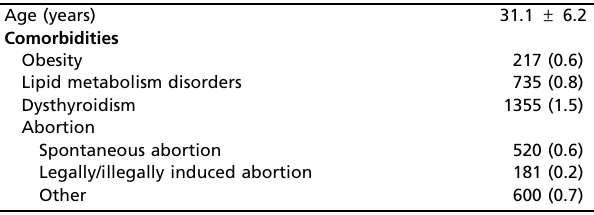
Figure 1 - Flow diagram of the patient selection process. Table 1 - Demographic characteristics and comorbidities of the entire cohort. (n =